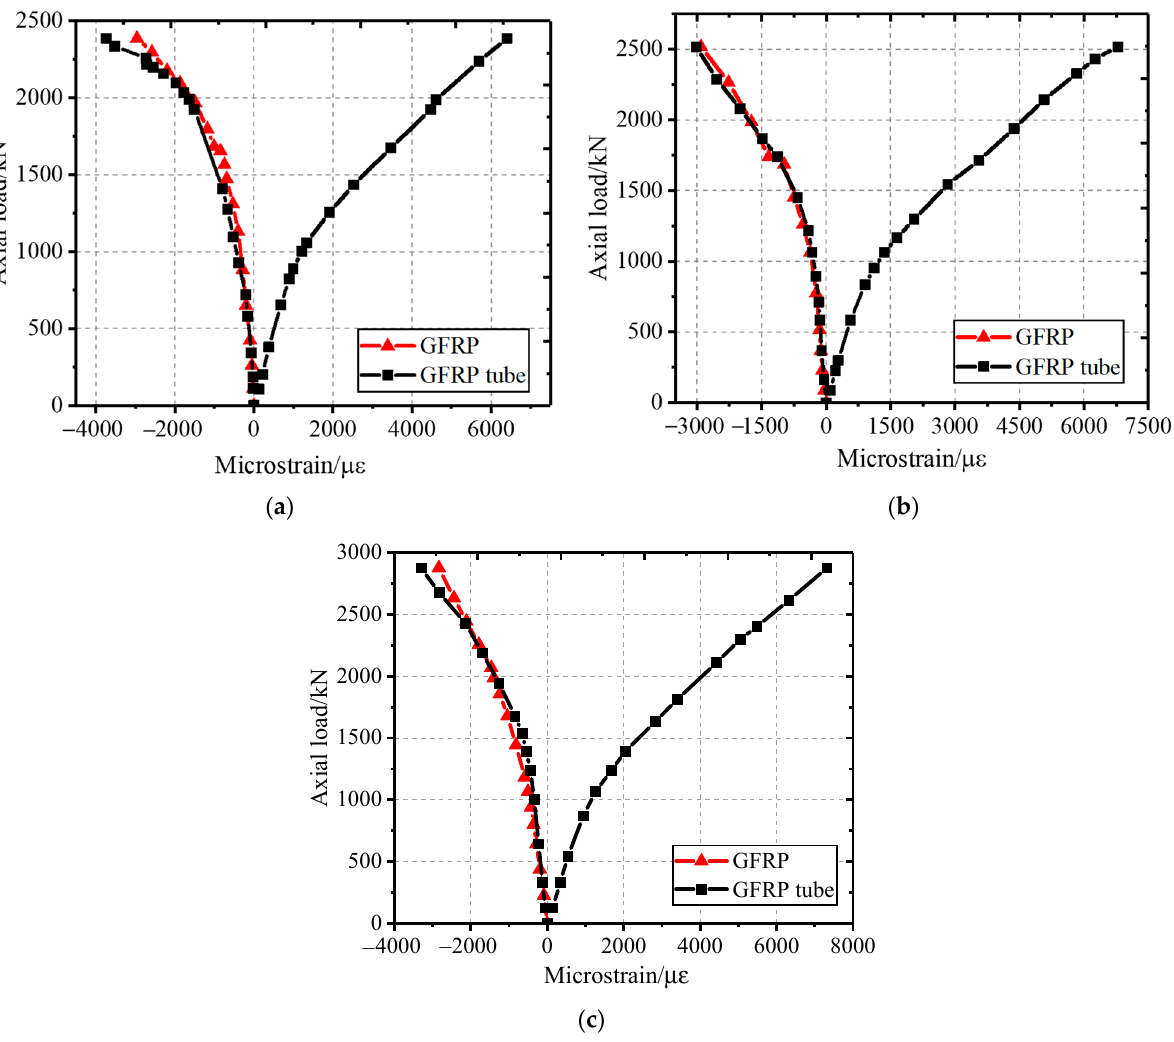
Figure 6. Axial load–strain relationship curve: ( a ) W50S85-1; ( b ) W50S40-2; ( c ) W600S0-2.